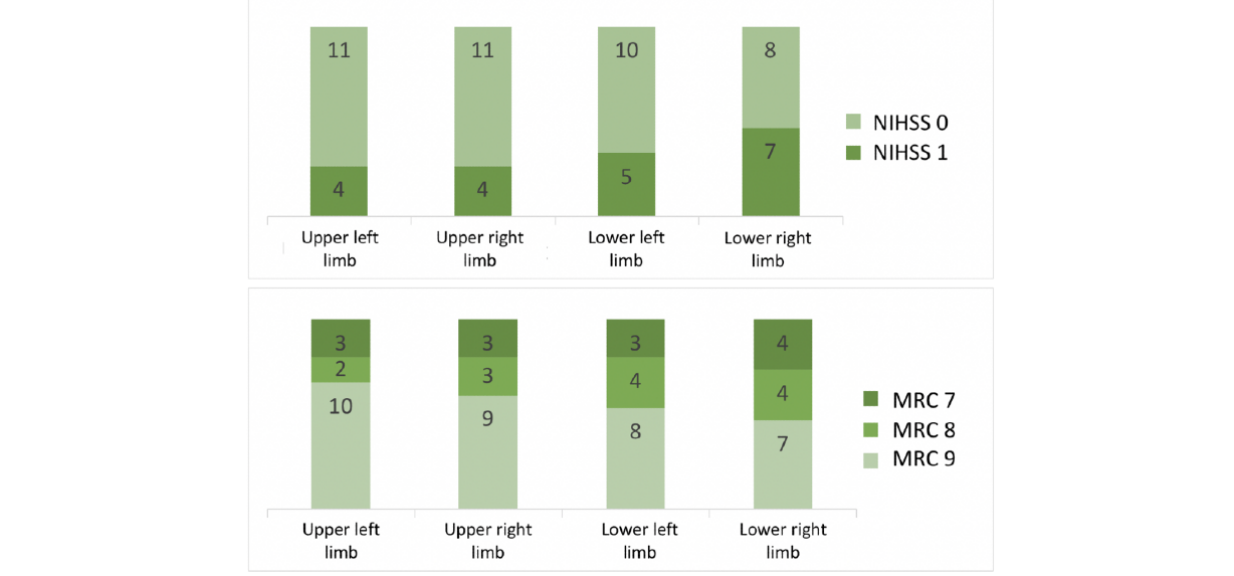
Figure 4. Grade distribution of NIHSS and MRC. MRC: Medical Research Council; NIHSS: National Institutes of Health Stroke